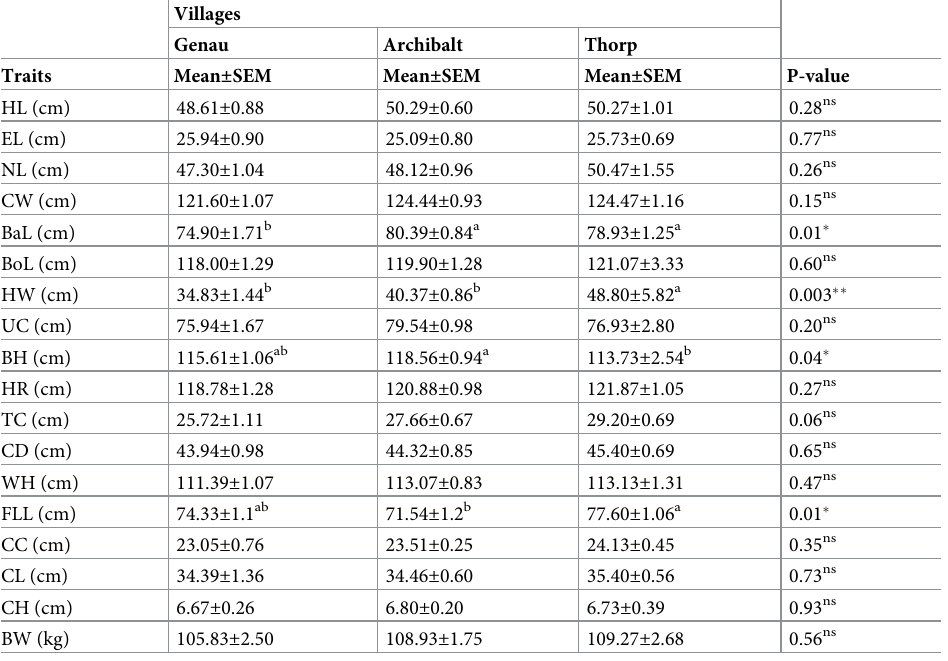
Table 7. Effect of village on morphological traits and body weight of